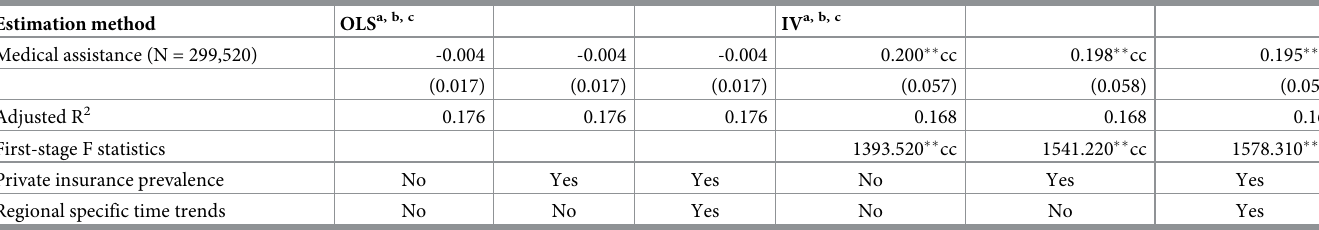
Table 2. The effect of medical assistance assignment on inpatient health care